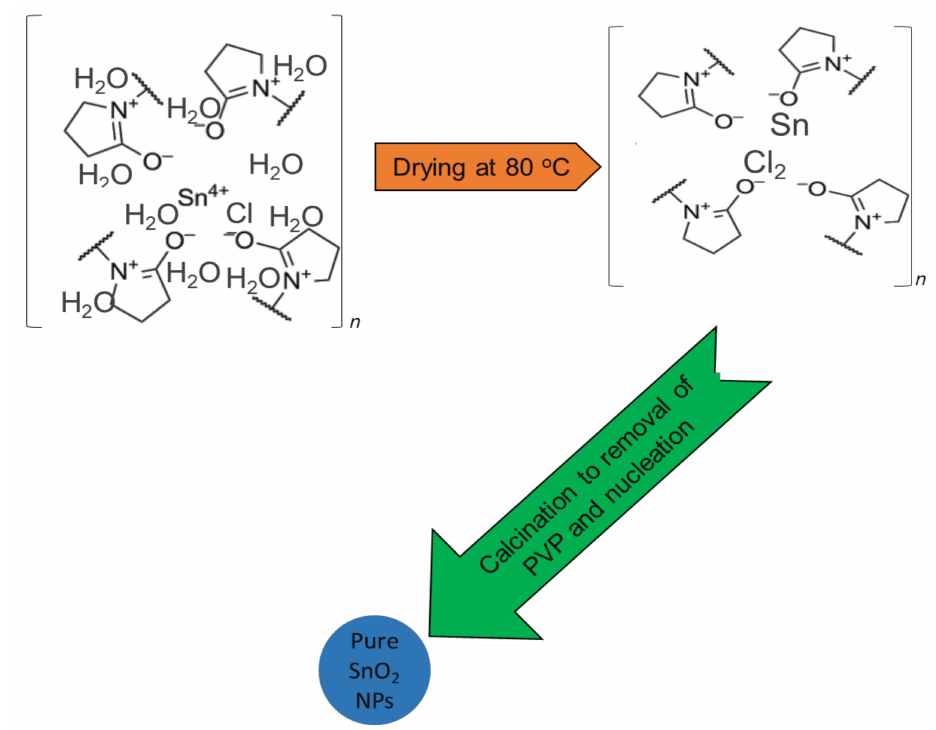
Figure 1. Nanoparticle growth mechanism.